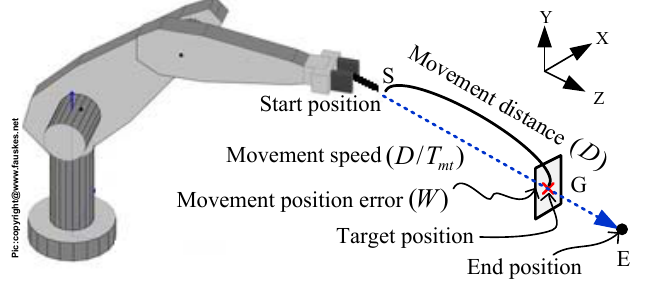
Figure 3. Scheme of our task, where the moving position error is defined as the error